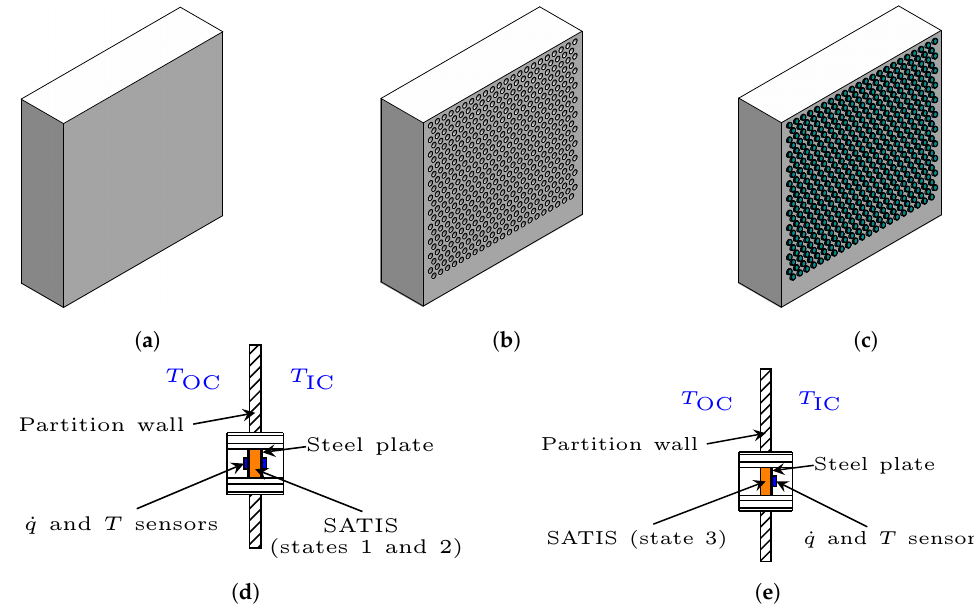
Figure 3. SATIS prototype in the manufacturing states 1, 2 and 3 and the experimental setups. ( a ) SATIS manufacturing state 1. ( b ) SATIS manufacturing state 2. ( c ) SATIS manufacturing state 3. ( d ) Setup for the experimental investigation of SATIS in states 1 and 2. ( e ) Setup for the experimental investigation of SATIS in state